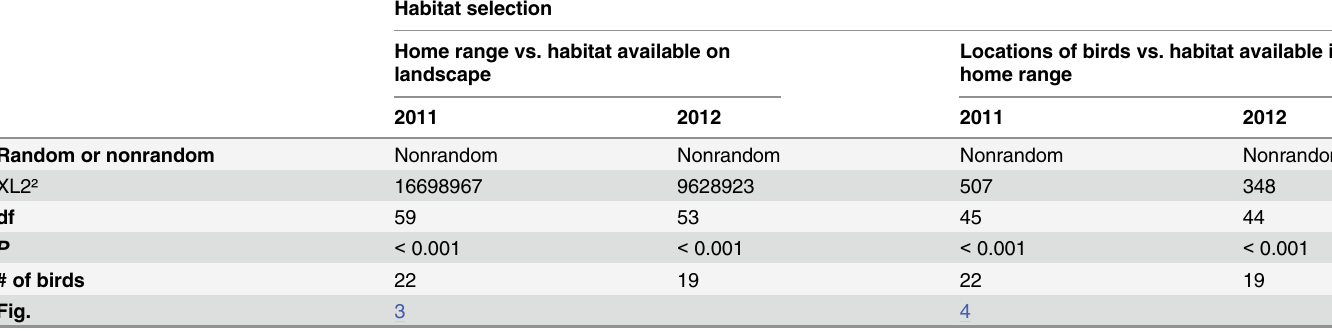
Table 4. Home range and within home range habitat selection.